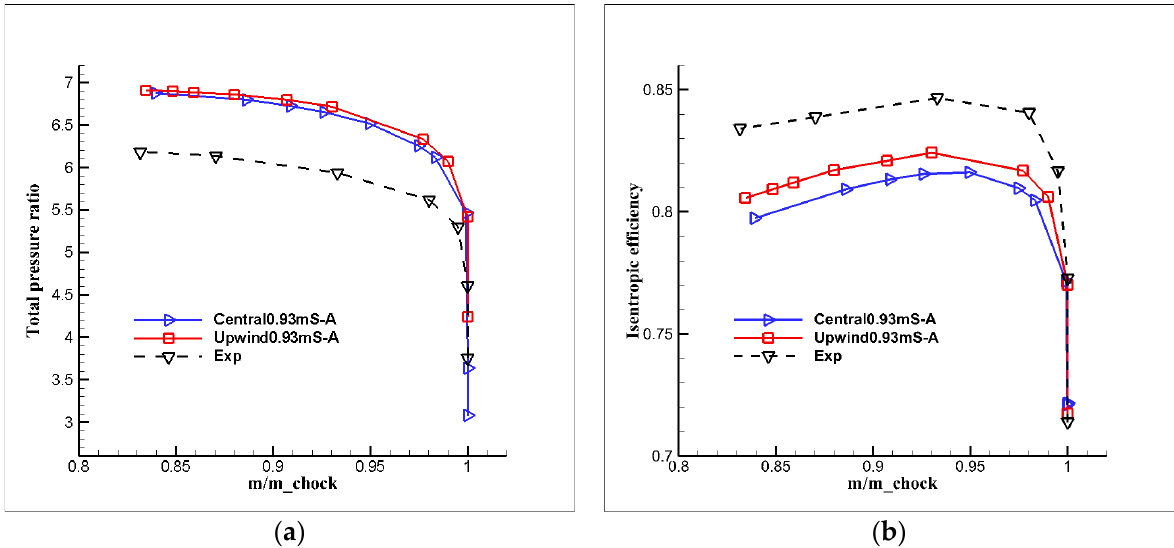
Figure 6. Compressor performance curves generated under different differential formats. ( a ) Total pressure ratio. ( b ) Isentropic efficiency.